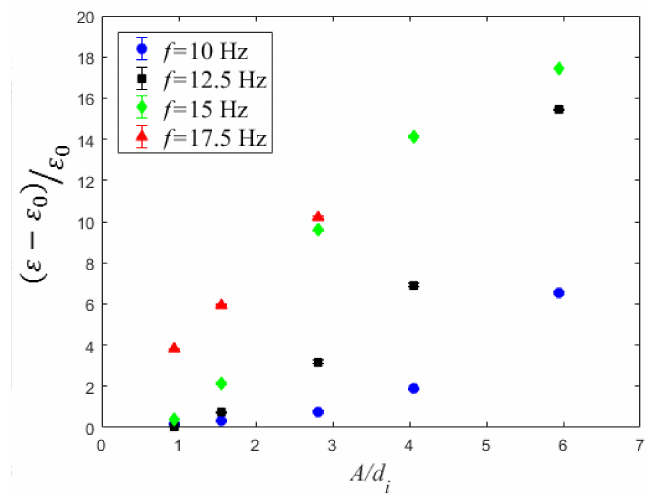
Figure 10. The void fraction ( ε ) scaled with the static column void fraction ( ε 0 ) plotted versus vibration amplitude ( A ) scaled with the injector tube diameter ( d i ). All data was collected at U SG = 5 mm/s. The current void fraction results are plotted versus M ( H ) and P m in Figure 11 as well as a power-law fit for each plot. These results are consistent with Waghmare et al. [18]. Also, Figure 11 demonstrates that the void fraction is dependent on both of these parameters; however, it shows a stronger dependency on M ( H ). The correlation between ε / ε 0 and M ( H ) supports the theory in Equation (15) that M ( H ) is a primary factor in scaling the void